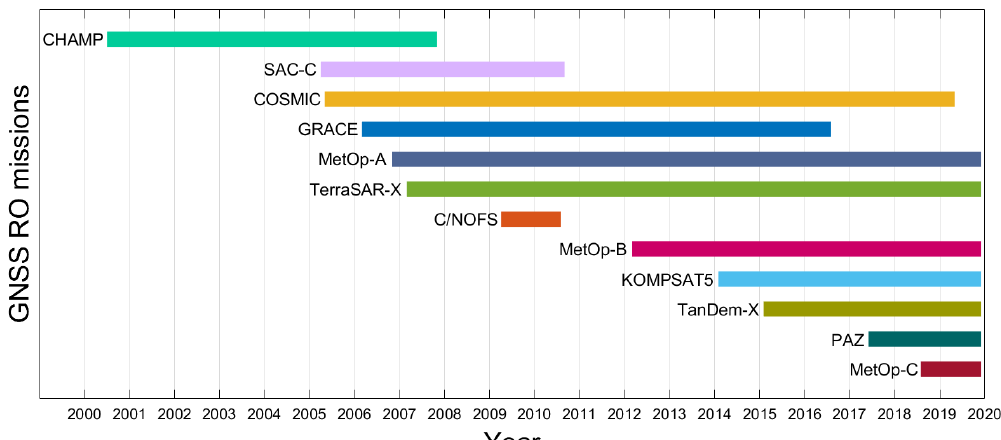
Figure 1. GNSS-RO data used in this